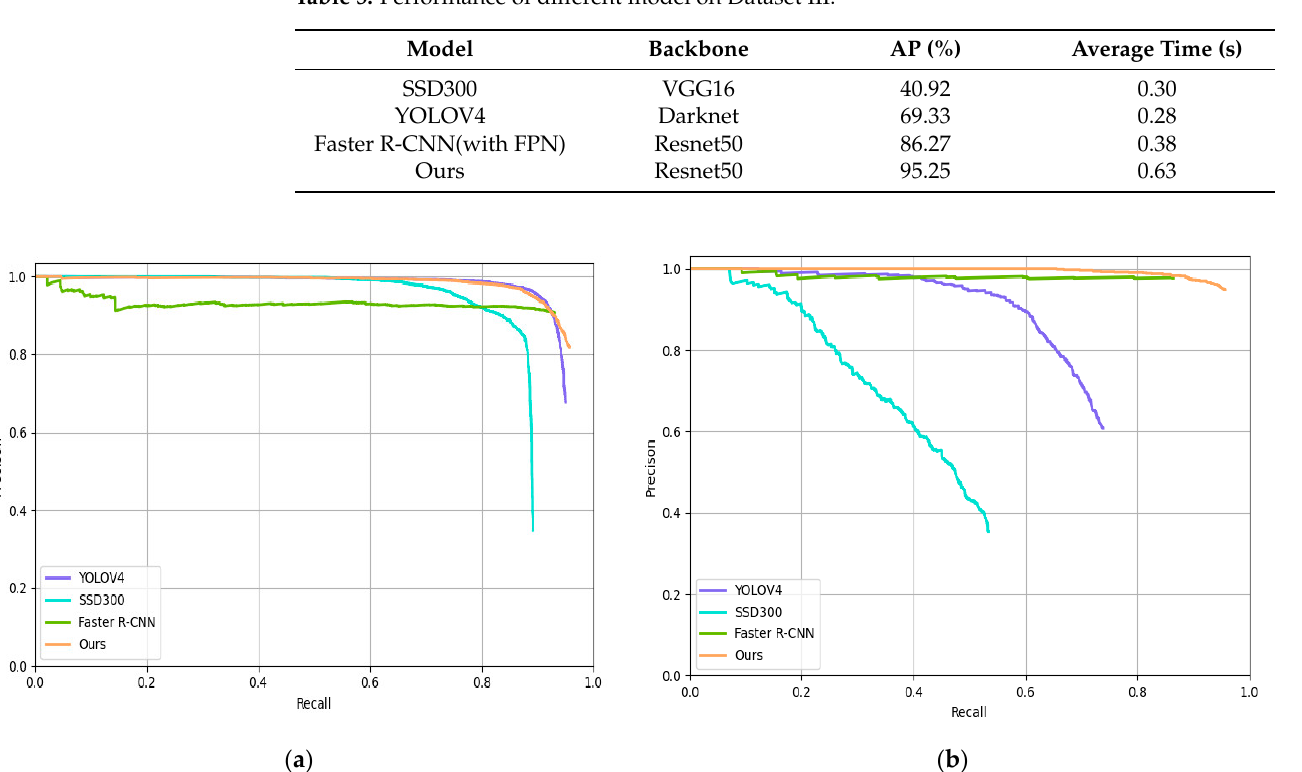
Table 5. Performance of different model on Dataset III.